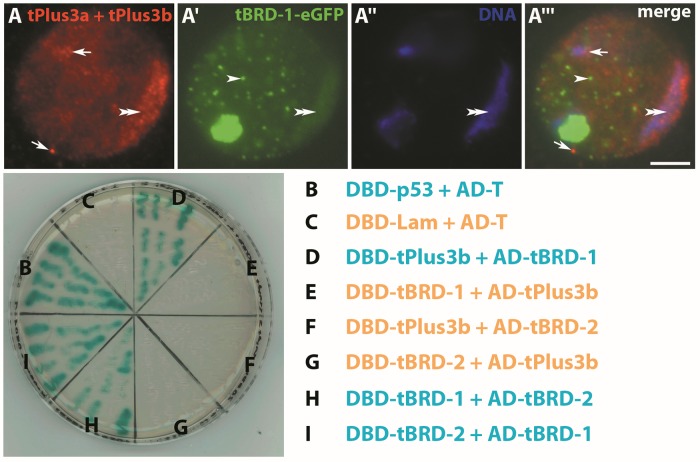
tPlus3a and tPlus3b partially co-localize with tBRD-1 and interact with tBRD-1 but not with tBRD-2 in yeast two-hybrid experiments.(A–A”‘) Anti-tPlus3a and tPlus3b immunofluorescence staining of a single spermatocyte nucleus of flies synthesizing tBRD-1-eGFP. (A) tPlus3a and tPlus3b signal present throughout the nucleus but concentrated in chromosomal regions (double arrowhead) and in distinct spots (arrows). (A’) tBRD-1 found mainly in the nucleolus, in chromosomal regions (double arrowhead), and in a speckled pattern (arrowhead). (A”) DNA stained with Hoechst. Double arrowhead, chromosomal regions. (A”‘) Merged image of A, A’, and A” showing co-localization of tPlus3a and tPlus3b and tBRD-1-eGFP in the chromosomal regions (double arrowhead). Scale bar = 5 μm. (B–I) Yeast two-hybrid interaction assay. (B) Positive control. (C) Negative control. (D) Heterodimerization of tPlus3b bait and tBRD-1 prey. (E) Lack of heterodimerization of tPlus3b prey and tBRD-1 bait. (F, G) Lack of heterodimerization of tPlus3b as bait or prey and tBRD-2 as prey or bait. (H, I) Heterodimerization of tBRD-1 and tBRD-2 as prey or bait.